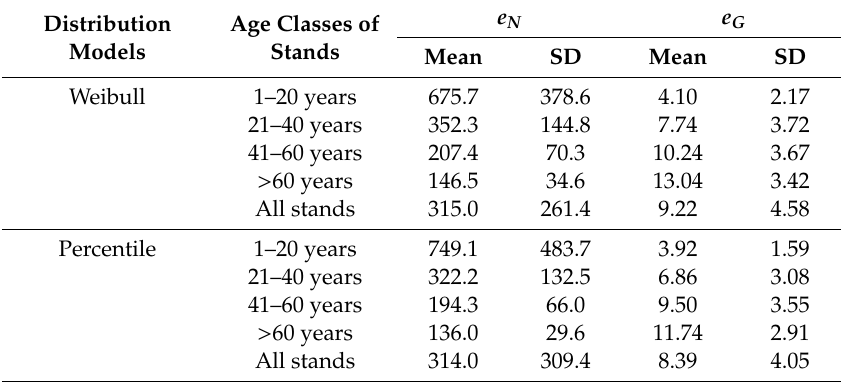
Figure 5. Distributions of error indexes e N ( a , b ), and e G ( c , d ) for the fitted Weibull and percentile models in black alder stands. Table 5. Error indexes e N and e G for the Weibull and percentile diameter distribution models for di ff erent stand age